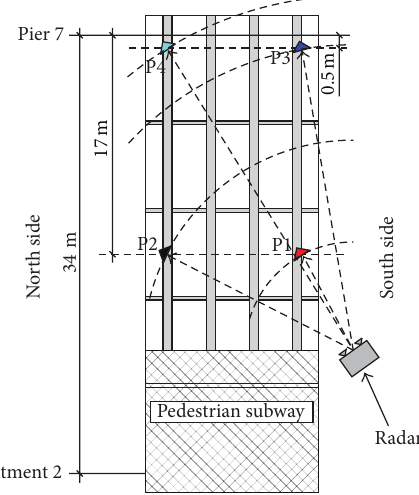
Figure 5: Measurement setup for the spam no. 8.